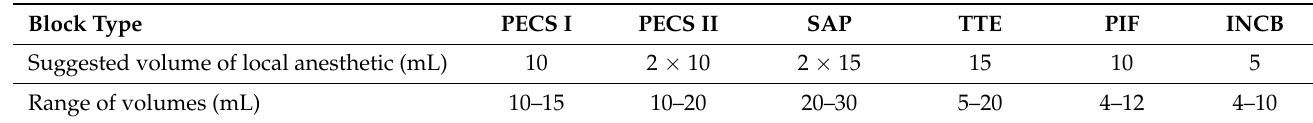
Table 1. Local anesthetic volumes used for described